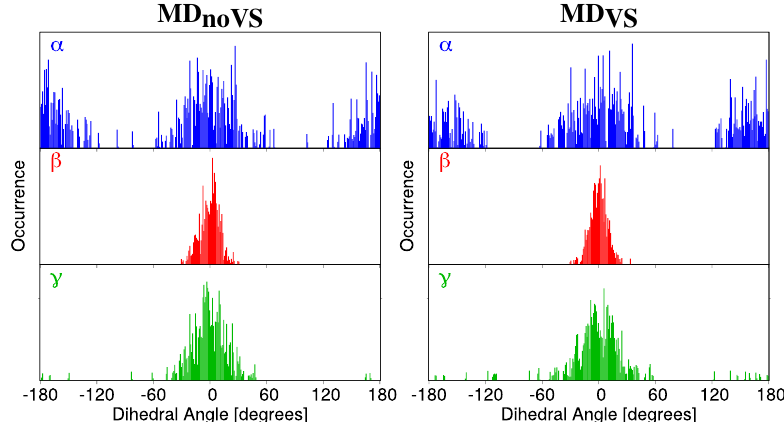
Figure 3. DDF of α (top,blue), β (middle,red) and γ (bottom,green) dihedral angles of Myricetin ( M ) as obtained from MD noVS ( left ) and MD VS ( right ).